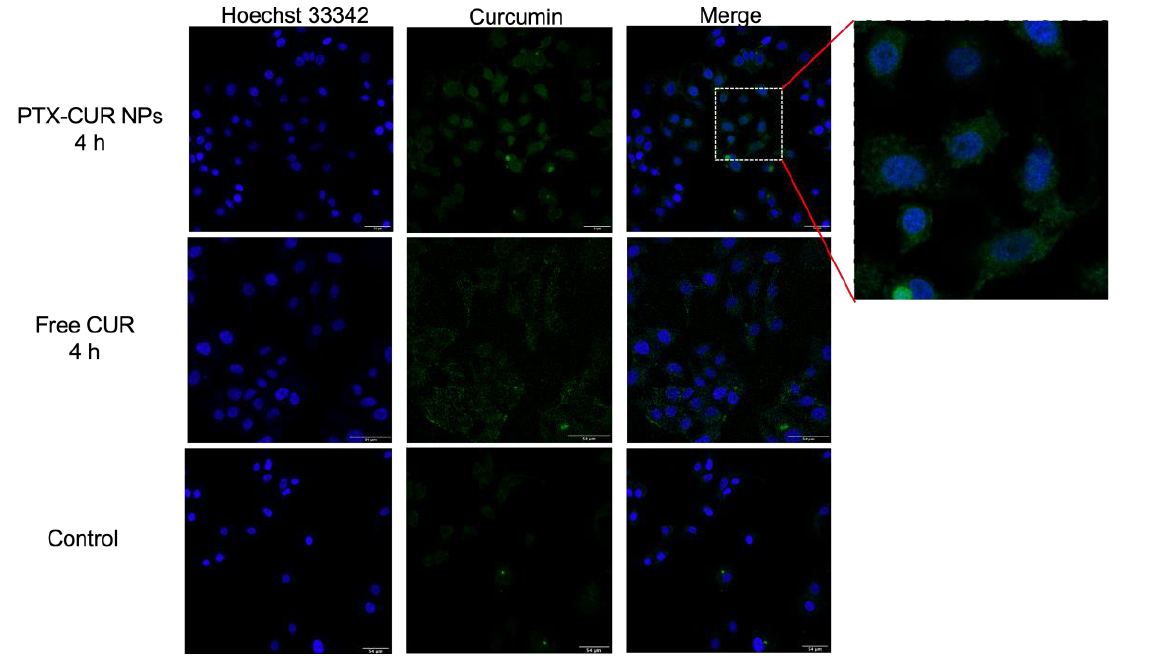
Figure 9. Confocal laser scanning microscopy images of MCF-7 cells after incubation with PTX-CUR NPs for 4 h. Scale bars are 54 m.